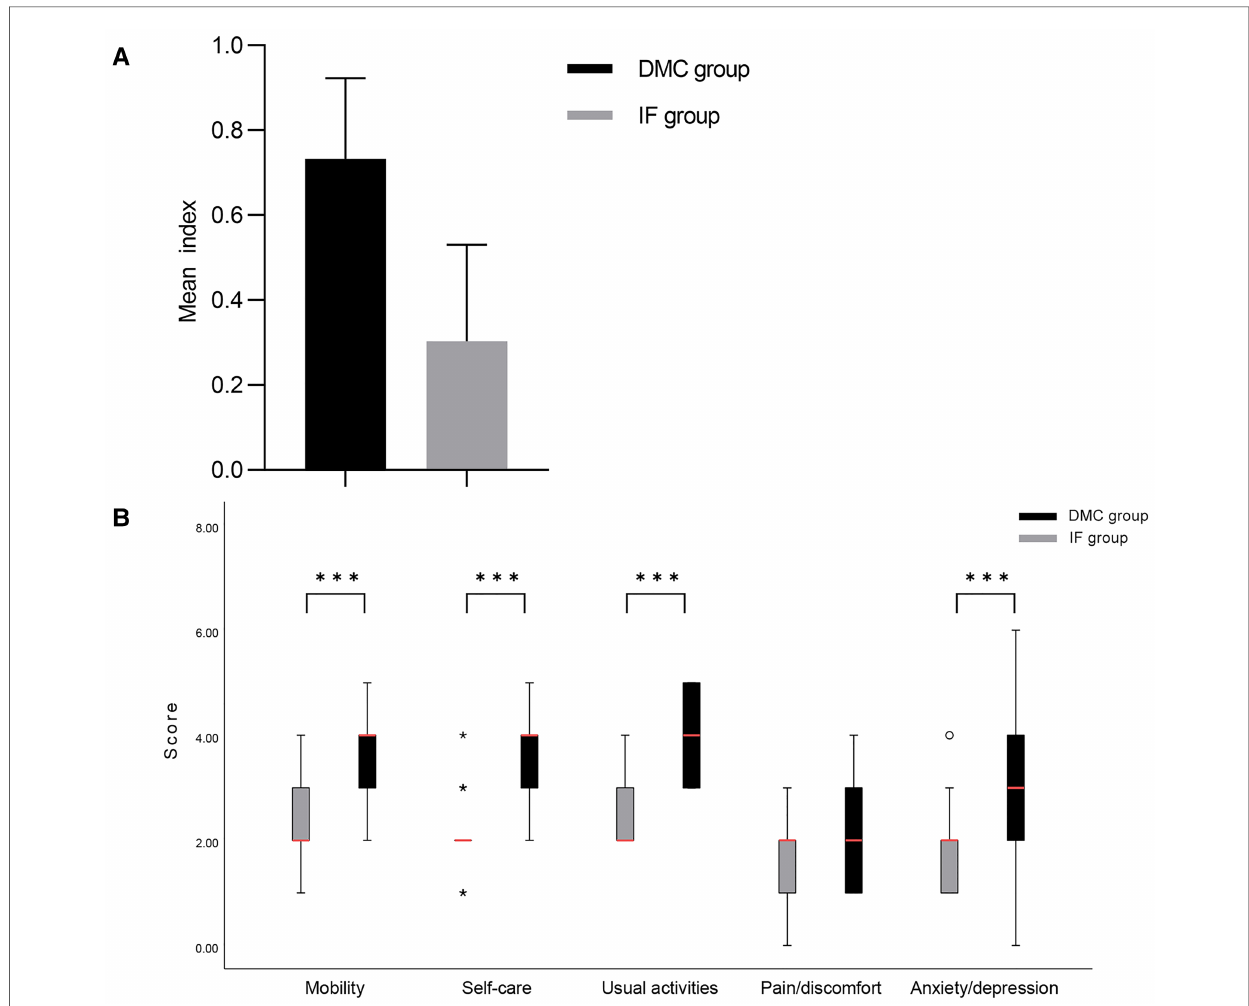
FIGURE 4 Scores for patient-related QOL assessed with the EQ-5D-5L. The results of the DMC group cohort are shown in black and the IF group cohort are illustrated in grey. ( A ) Comparison of EQ-5D-5L utility index between DMC group and IF group. ( B ) Comparison between DMC group and IF group on subdimension scores of EQ-5D-5L.